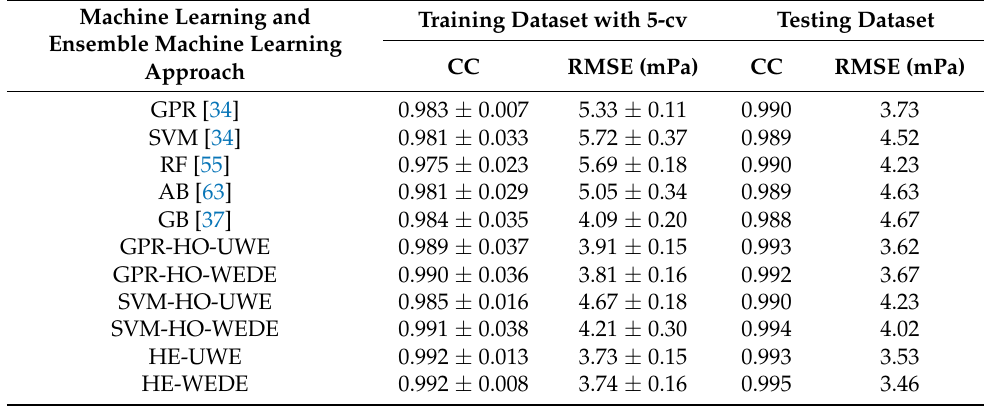
Table 11. Performance of different machine learning models on the FSW-11PI-V1